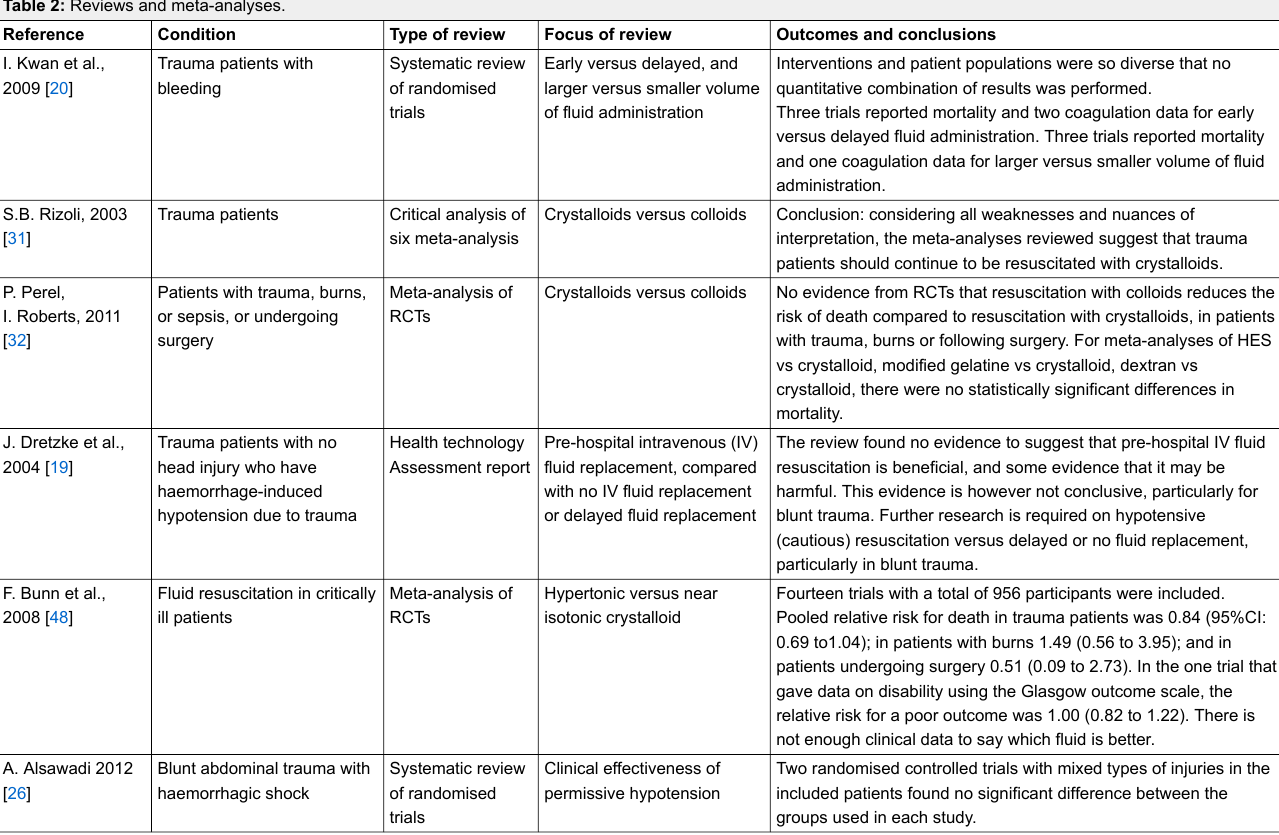
Table 2: Reviews and